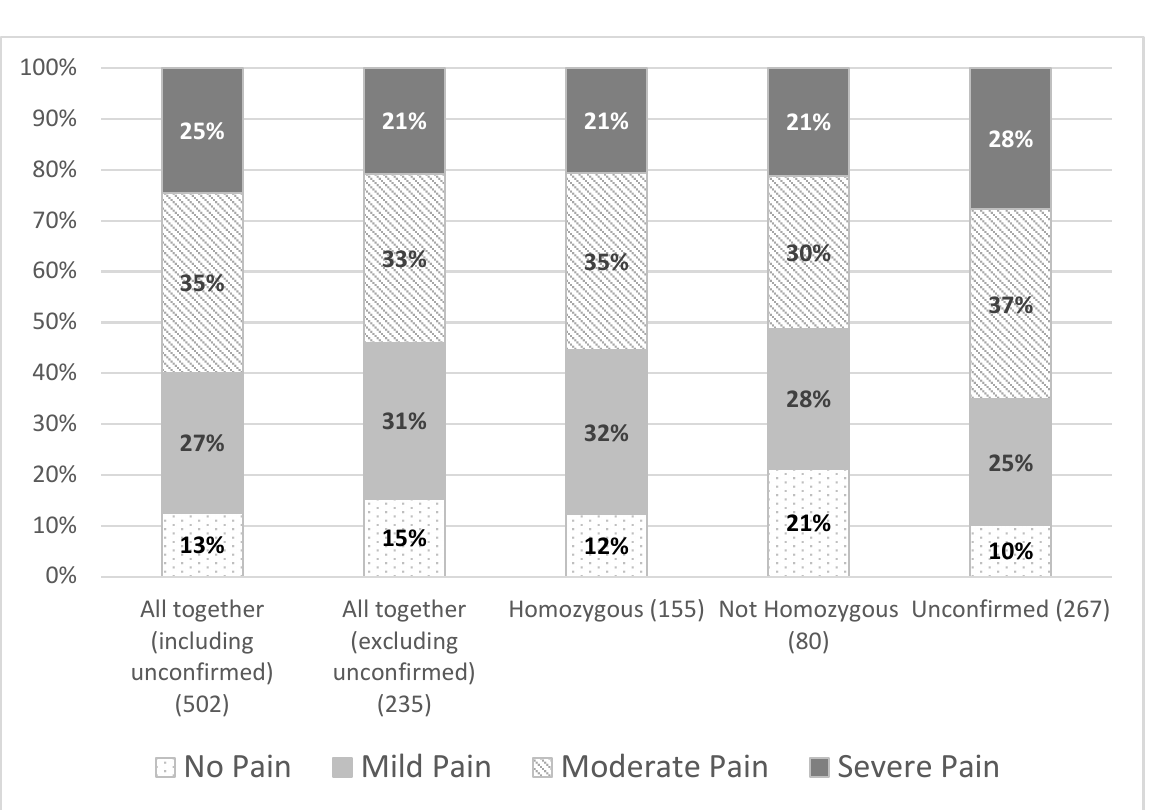
Figure 1. Severity of pain by LGMDR9 type.